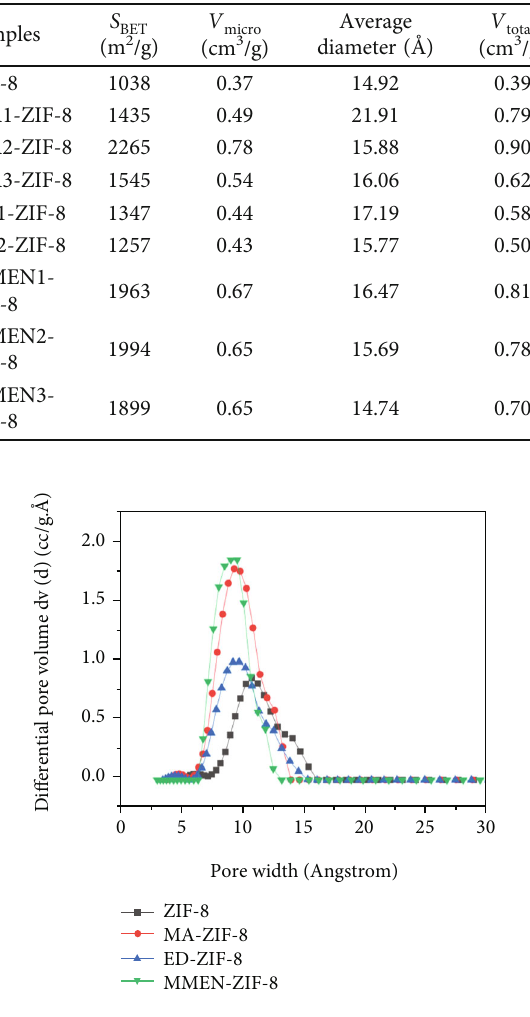
Figure 3: DFT pore size distribution for ZIF-8 and amine-modi fi ed ZIF-8 materials.